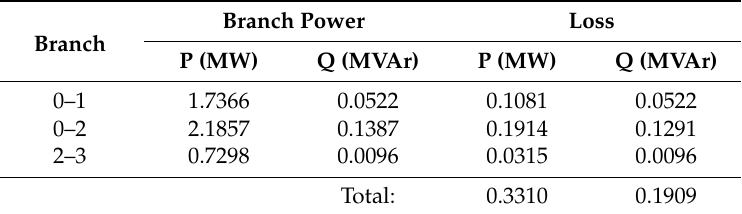
Table 3. Original branch data.